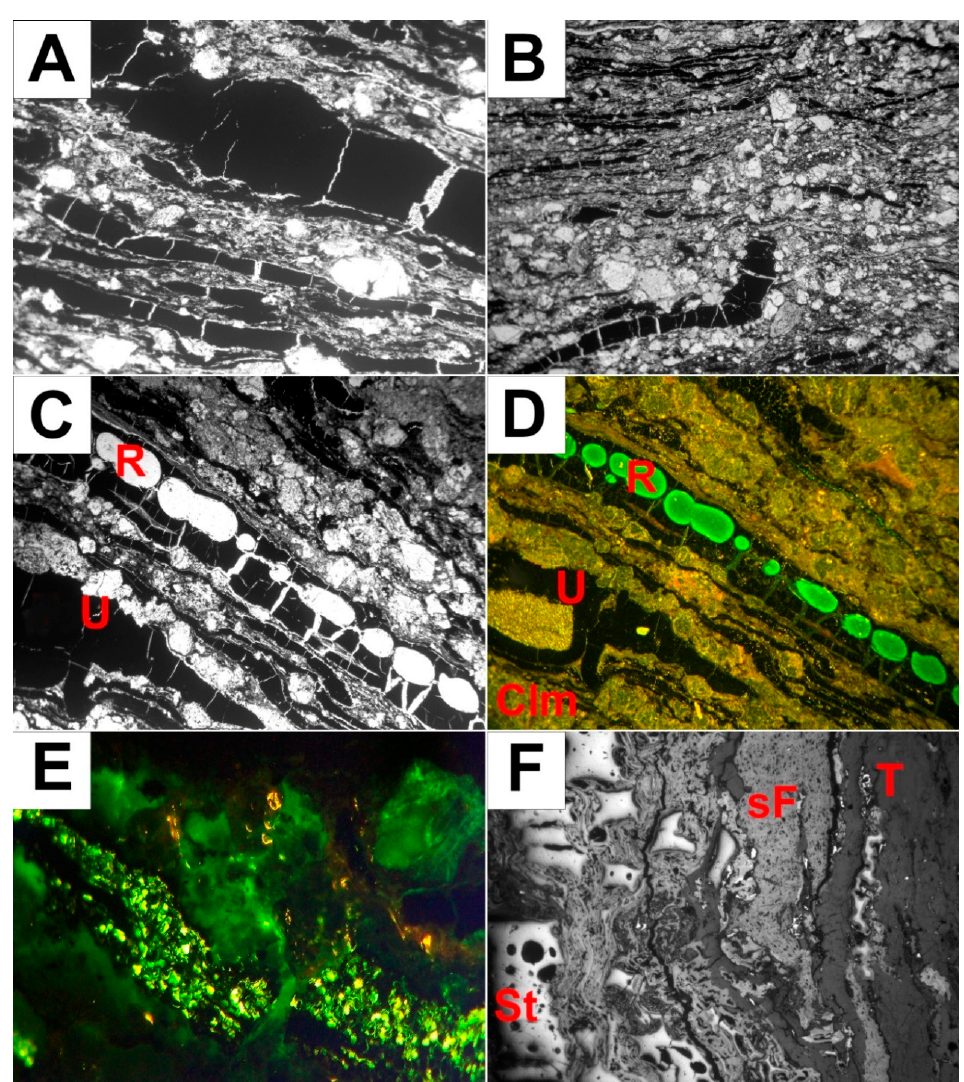
Figure 4. Microphotographs of coaly shale. The linear nature of the rock under polarized transmitted light: ( A ) Magnification 125×; ( B ) 75×; clusters of resinite (R) in ulminite (U) films and clay minerals (Clm): ( C ) Transmitted white light, 75×; ( D ) Reflected light, blue fluorescent, 75×; ( E ) Clusters of fluorinite and liptodetrinite in coal (reflected light, blue fluorescent, 500×; ( F ) Secretinite (St), semifusinite (sF) and textinite (T) inclusions in coal (polarized reflected light, 500×).